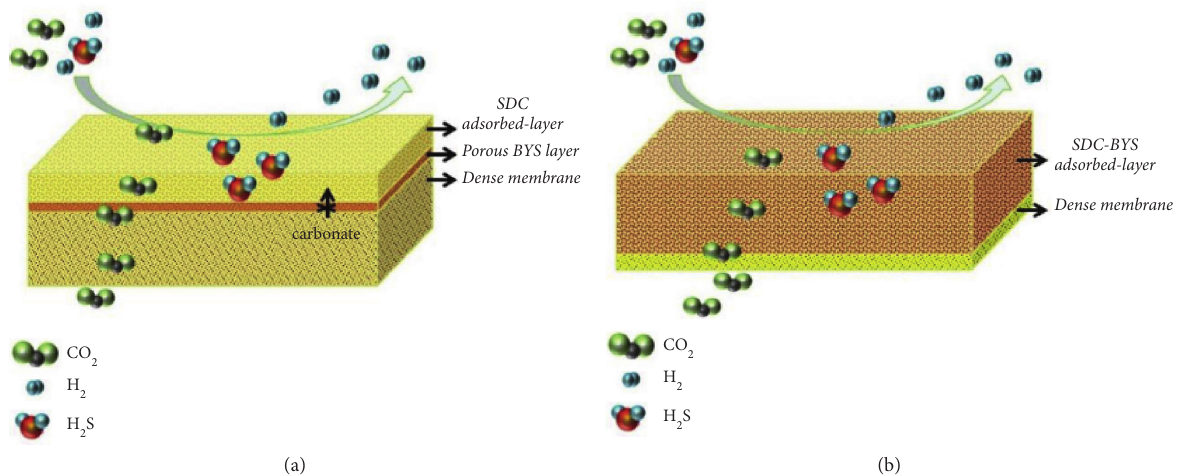
Figure 7: Asymmetric membranes for carbon capture in H